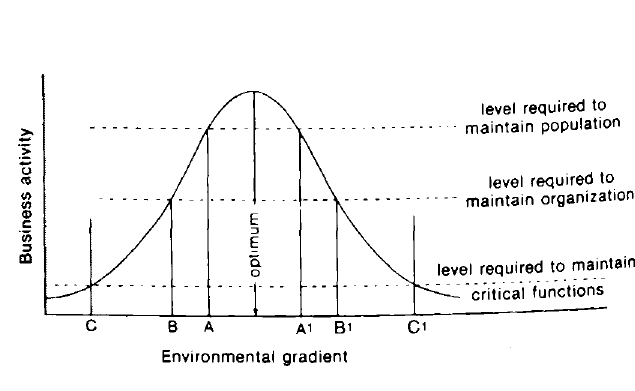
Figure 9 Business activity and 1he